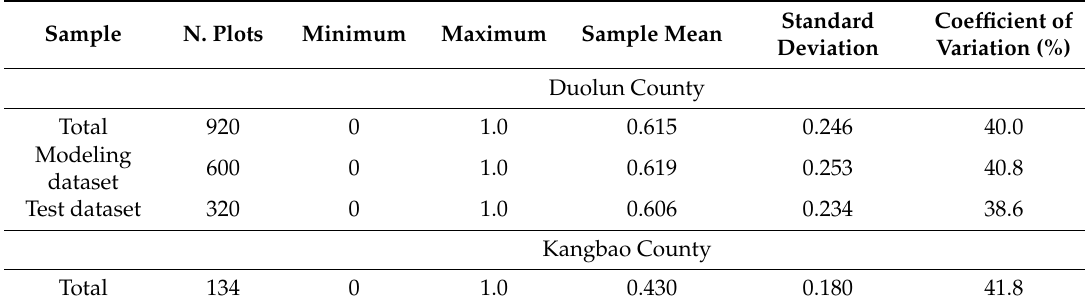
Table 2. The statistical summary of sample plot data used for mapping PVC for Duolun and Kangbao